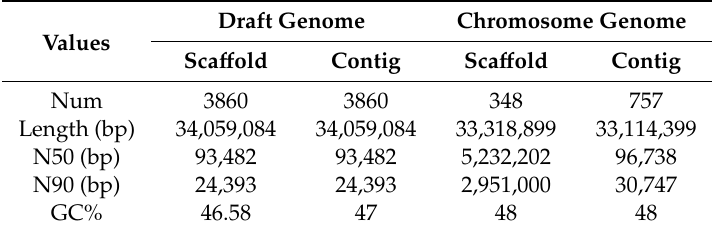
Table 1. Statistic of genome